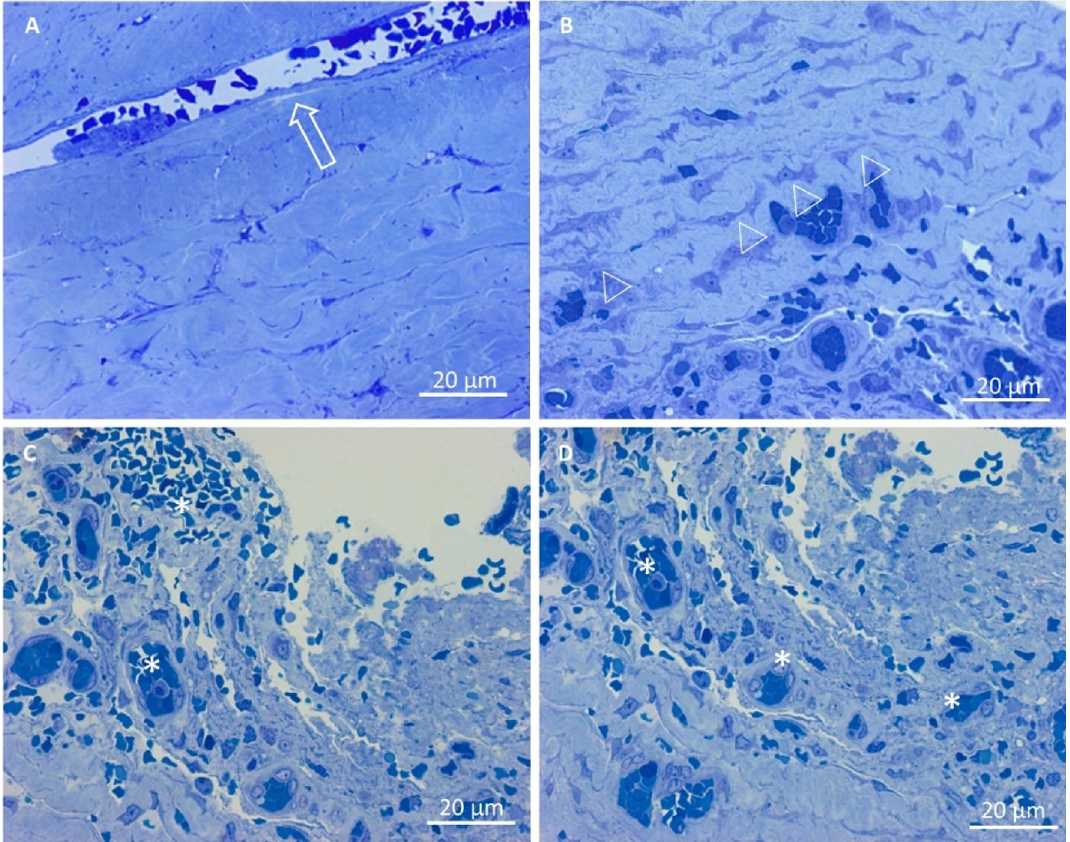
Figure 7. Light microscopy on semi-thin sections stained with methylene blue. ( A ) CSDH outer membrane. Flattened cells were surrounded by large bundles of collagen fibers, strictly packed and interwoven. A macro capillary was observed (arrows). ( B ) CSDH inner membrane. Various types of cells were arranged as regular ties (arrowheads), in a loose network of collagen fibers. ( C , D ) In the side of the inner membrane facing the hematoma cavity, an increased number of various-sized capillaries (asterisks) were detected along with a disorganised network of collagen fibers. ( A – D ): 400 ×, Bar = 20